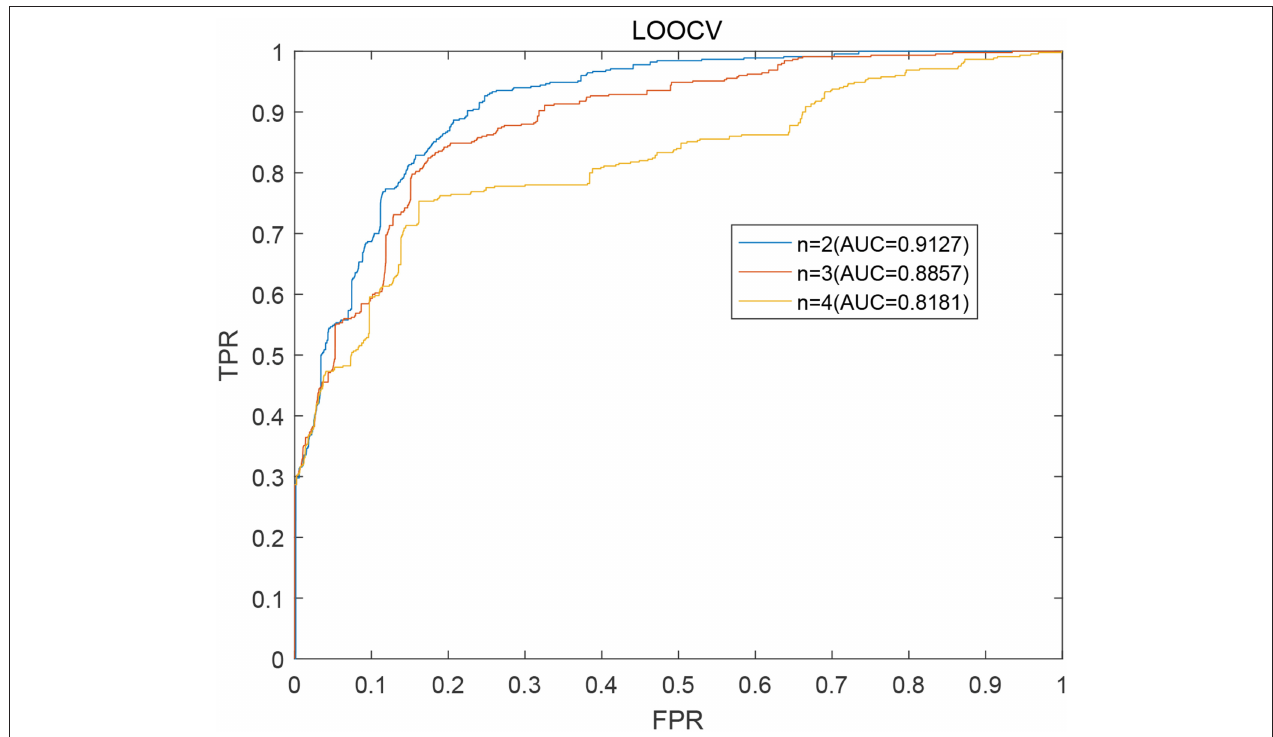
FIGURE 3 | AUCs achieved by BWNMHMDA in LOOCV while n = 2, 3, 4